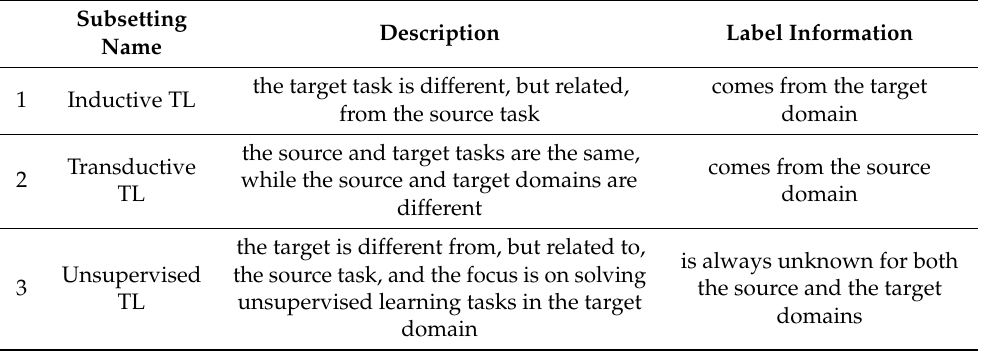
Table 1. Transfer learning subsettings.